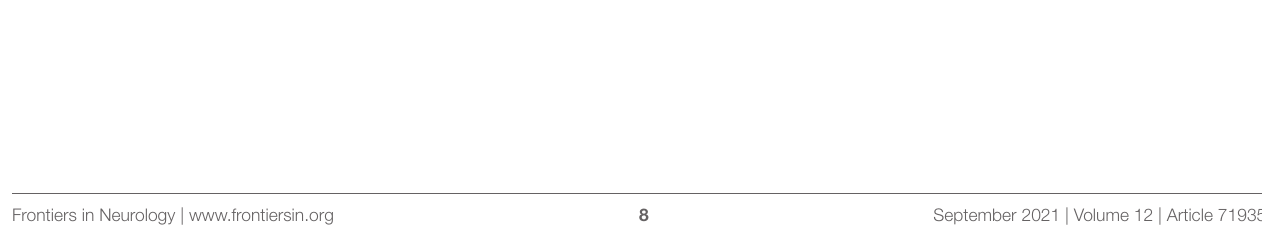
Frontiers in Neurology |